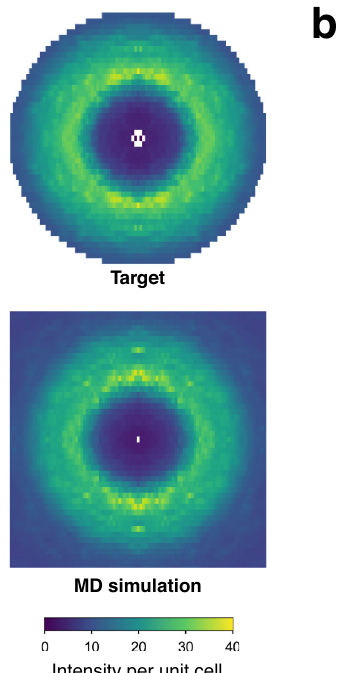
intensity (top panel) agrees well between the target (black symbols) and MD (blue symbols). After subtracting the average (see Methods), the standard deviation of intensityiscloselymatchedbyMD(middlepanel,blackvs.bluesymbols),including a distinctive shoulder at d ~ 2 Å. The Pearson correlation coef fi cient (CC, bottom panel) between MD simulation and target diffuse map is best at low resolution (CC ∼ 0.8) and decays slightly at high resolution. Source data are provided as a Source Data fi